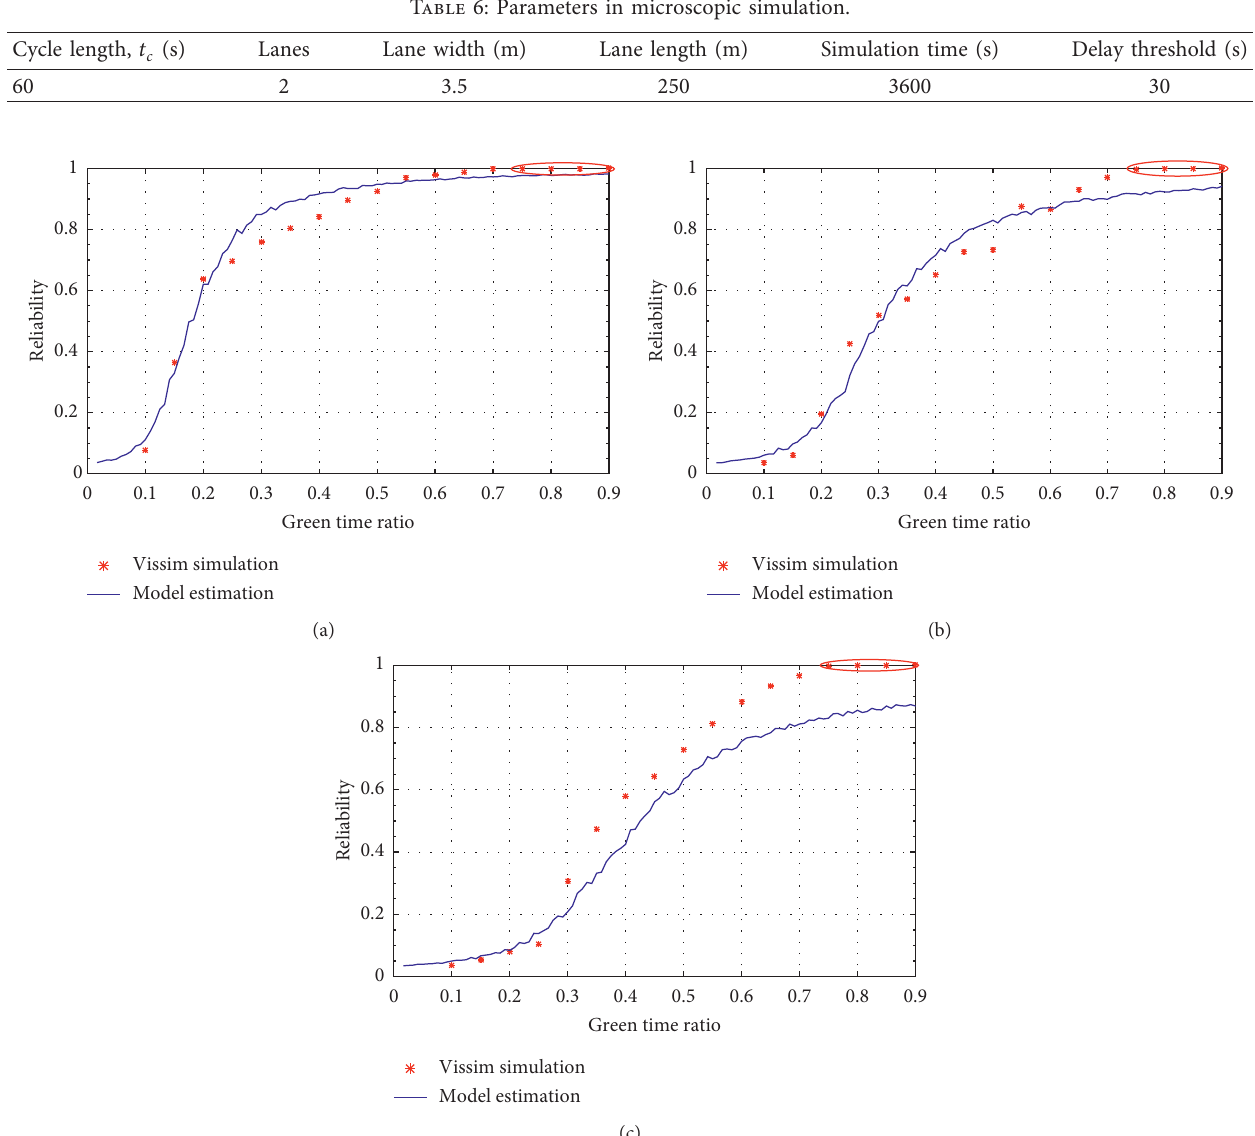
Figure 13: A comparison between microsimulation calculation and model estimation. (a) v / c � 0.3, (b) v / c � 0.5, and (c) v / c �